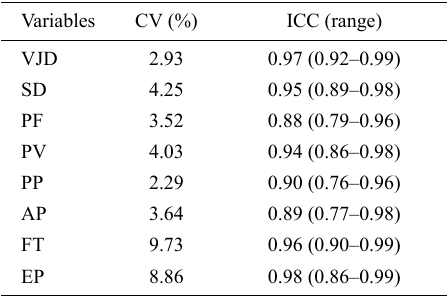
Table 2. During the CMJ, the coefficients of variation (CV), intraclass correlation coefficients (ICC), and related 95% confidence limits for variables (n = 96).